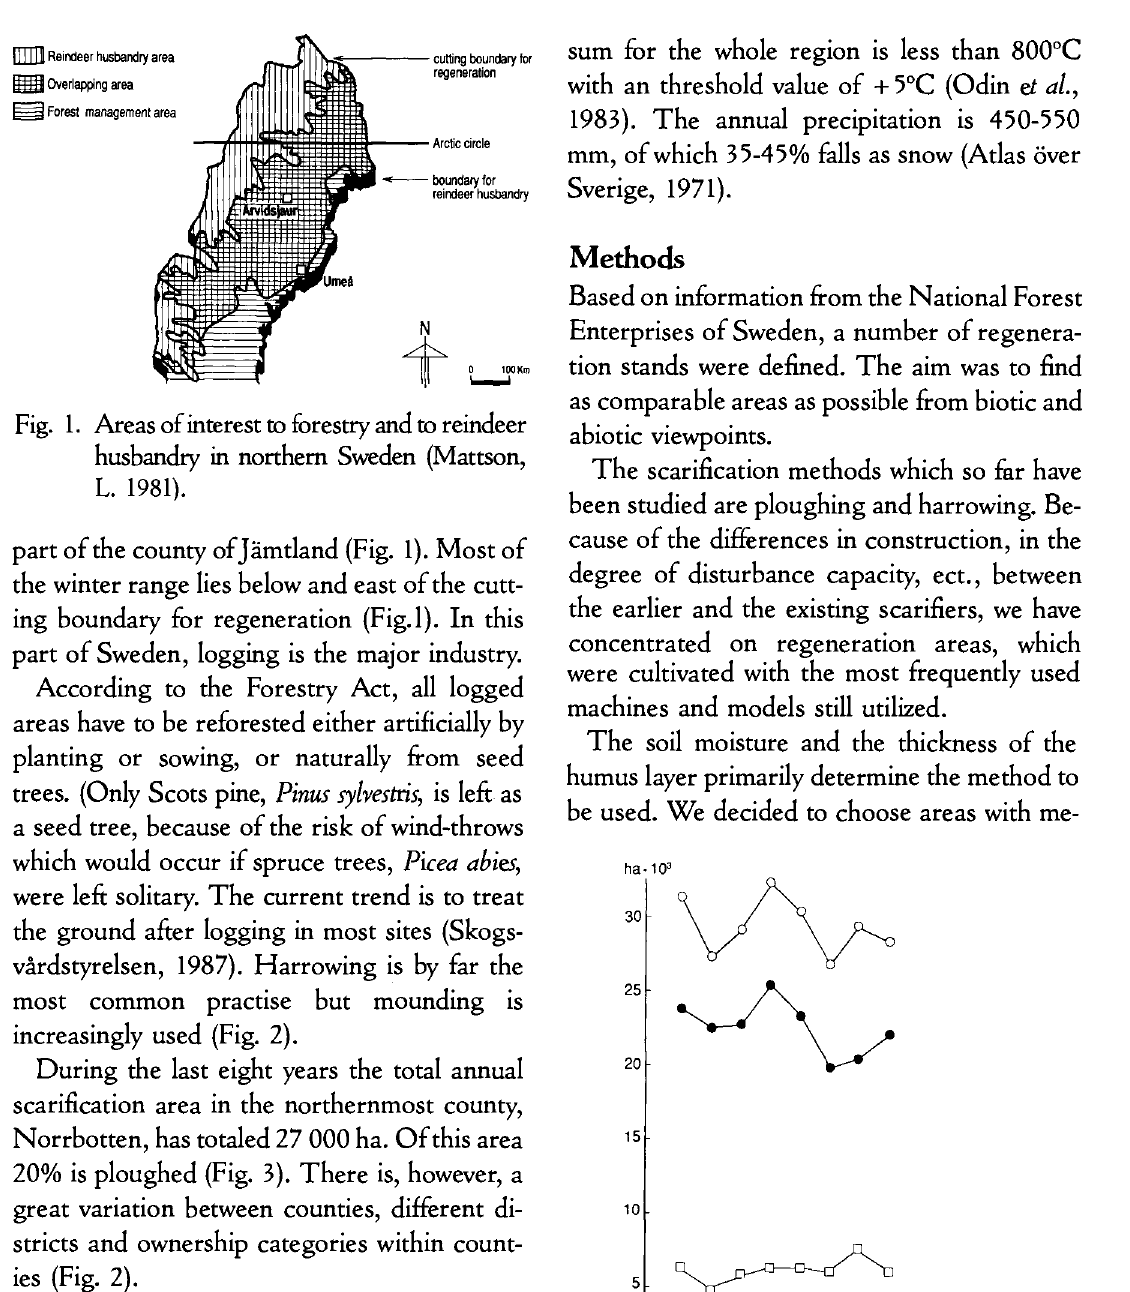
Fig. 1. Areas of interest to forestry and to reindeer husbandry in northern Sweden (Mattson, L. 1981).